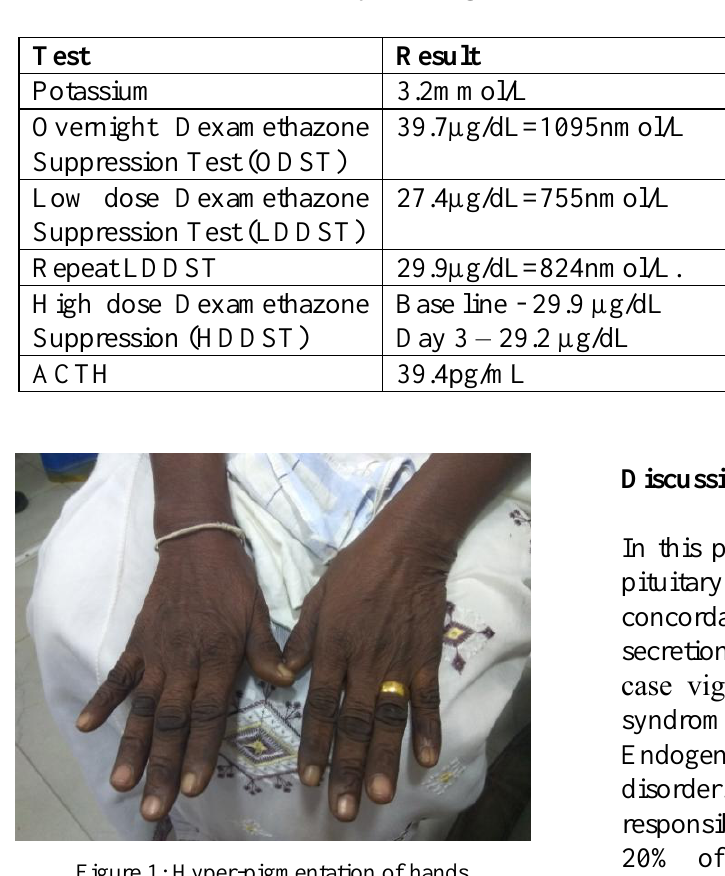
Table: Results of laboratory investigations